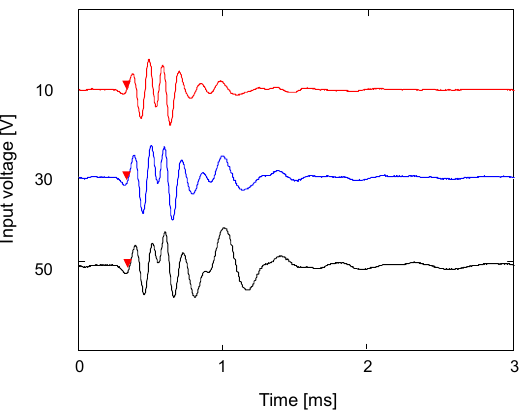
Figure 6. Variation in waveform along with the input voltage for ring bender. The red triangle denotes the first arrival time.